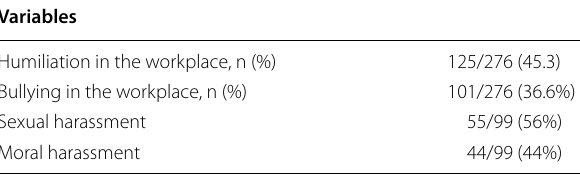
Table 5 Humiliation and bullying in the workplace